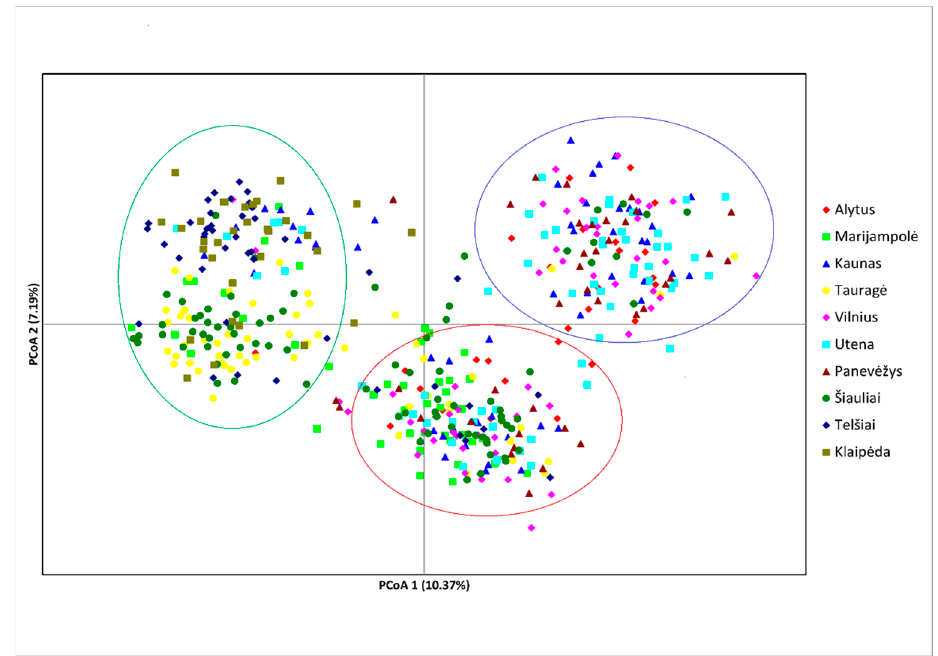
Figure 3. PCoA plot based on the genetic distance matrix of 491 wild boars collected from the sampling sites. Data obtained from analysis of 13 polymorphic microsatellite loci were used. A green ellipse indicates the grouping of almost all individuals from the western region, red and blue ellipses indicate that the remaining individuals from other regions tend to split into two mixed groups.